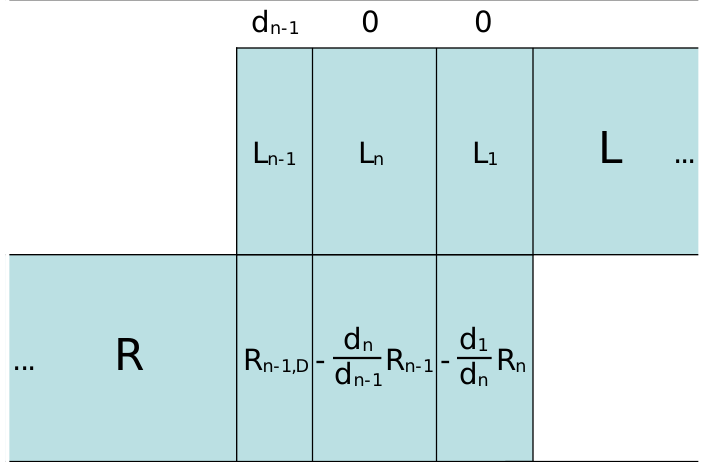
Figure 10 . Not manifestly positive matrix structure containing three overlapped sub-columns.